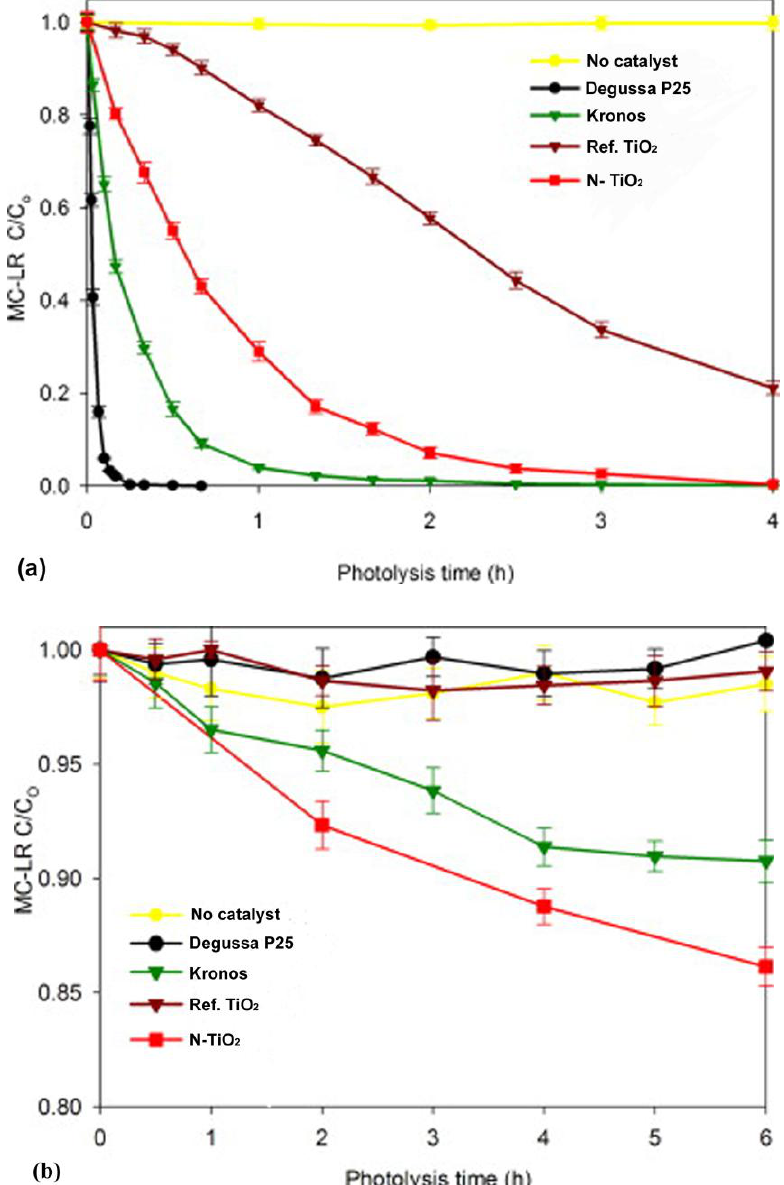
Figure 5. Photocatalytic degradation of microcystin-LR under (a) solar light irradiation and (b) visible light (440–460 nm), in the presence of commercial (P25 and Kronos), reference (Ref-TiO ), and nitrogen-doped (N-TiO ) TiO materials. (Reprinted from [51]. Copyright 2 2 2 (2012), with permission from